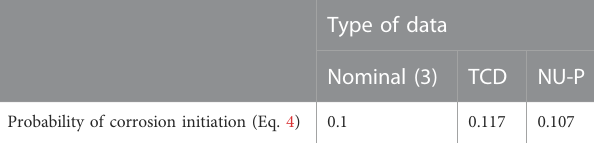
TABLE 6 Probability of corrosion initiation computed with the parameter of Fick ’ s law of the three pro fi les of the chloride